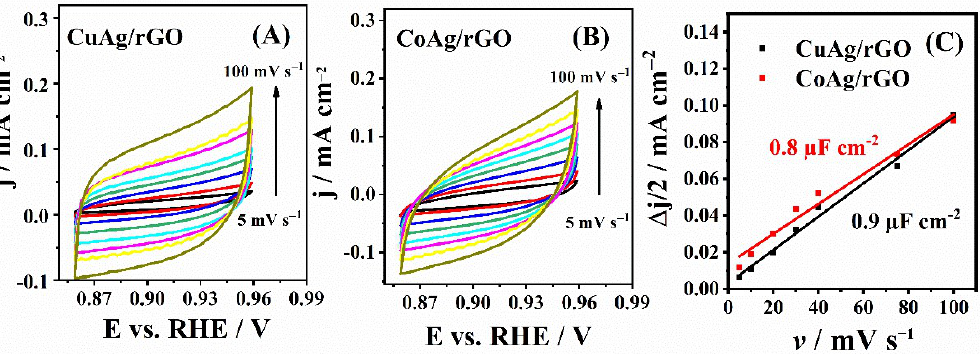
Figure 4. CVs of CuAg/rGO ( A ) and CoAg/rGO ( B ) electrocatalysts and the corresponding double- layer capacitance plots ( C ) in N2-saturated 0.1 M KOH solution at different scan rates.